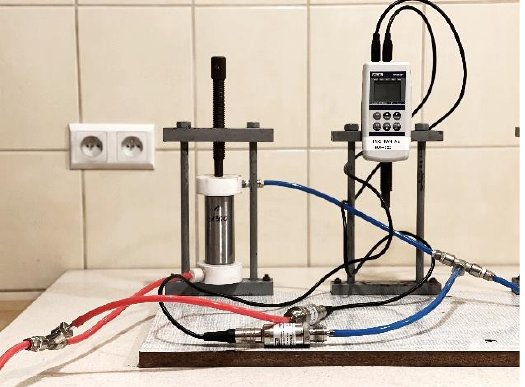
Figure 2. Original setup for gas permeability testing of post-process waste: red line is nitrogen inlet; blue line is nitrogen outlet (B. Dutka).